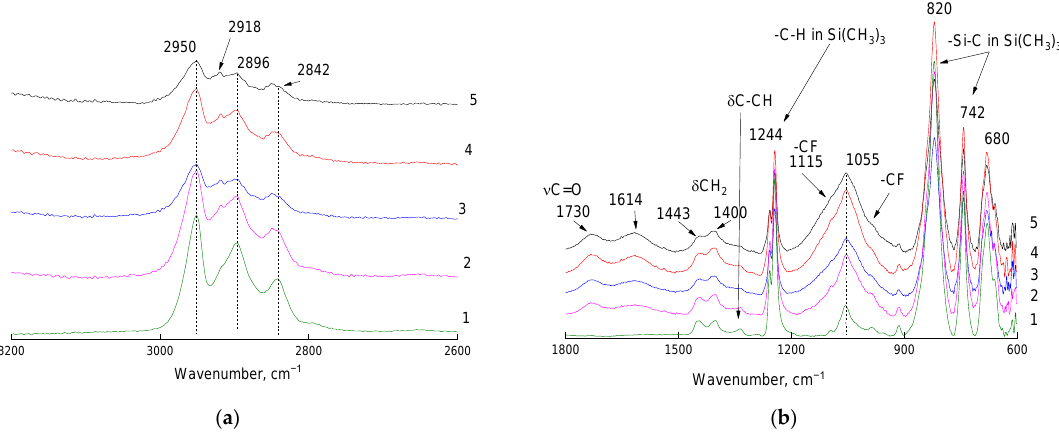
Figure 2. Fragments (( a ): 2600–3200 cm −1 region; ( b ): 600–1800 cm −1 region) of the ATR-IR spectra (ZnSe crystal) of the PVTMS film recorded on the side of fluorination. Curve 1: original film; curves 2–5: films fluorinated for 15, 30, 45, and 60 min, respectively.